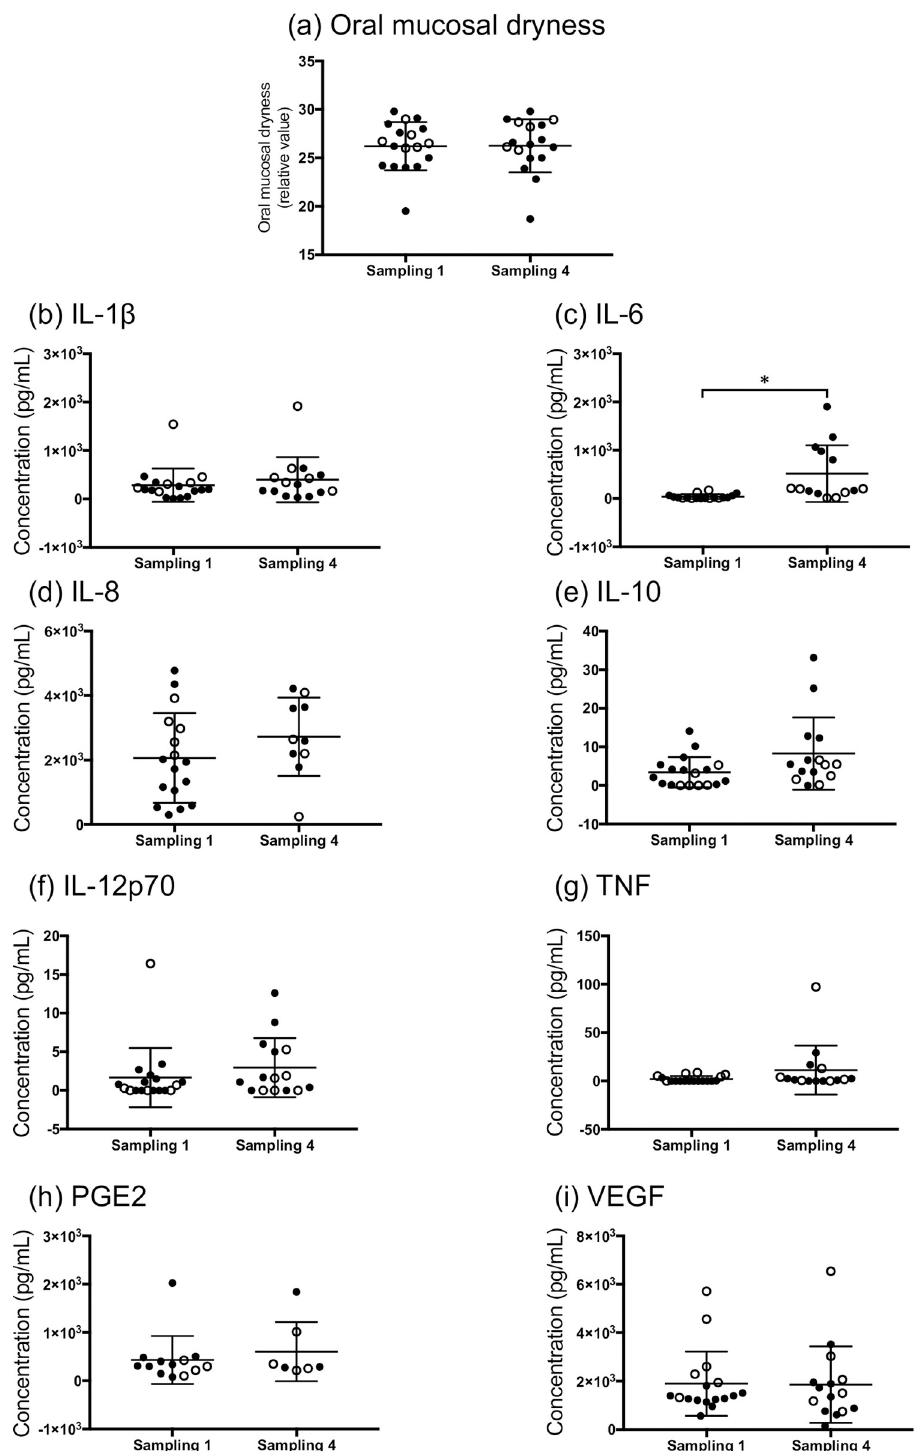
Fig 4. Concentration differences in oral mucosal dryness and salivary inflammatory mediators between sampling point 1 and 4. (a) Oral mucosal dryness, (b) IL-1 β , (c) IL-6, (d) IL-8, (e) IL-10, (f) IL-12p70, (g) TNF, (h) PGE2, and (i) VEGF. Data are shown as mean ± standard deviation. The closed circles represent patients with leukemia, while the open circles represent patients with head and neck carcinoma. Sampling was done in group 1 and 4 before and after cancer treatment, as described in the methods section. The statistical differences between the sampled 1 and 4 groups were analyzed using the Mann–Whitney U test ( � p < 0.05). https://doi.org/10.1371/journal.pone.0267092.g004 PLOS ONE | https://doi.org/10.1371/journal.pone.0267092 April 27,